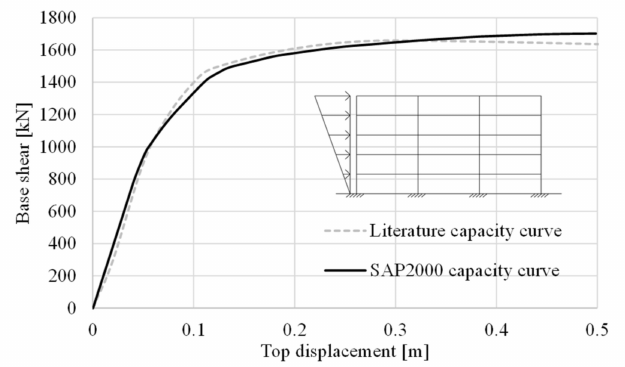
Figure 8. Comparison of the capacity curves. Table 1. Calculated plastic hinge properties.